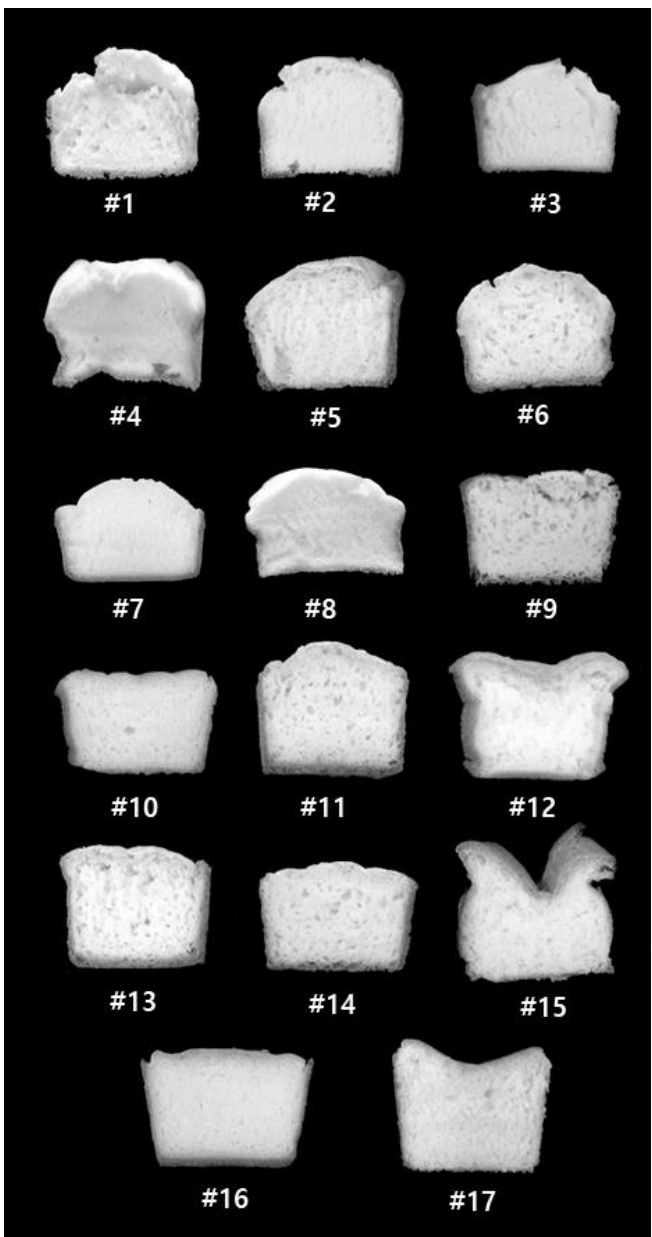
Figure 2. Cross-sections of gluten-free rice bread tested by a full factorial design.